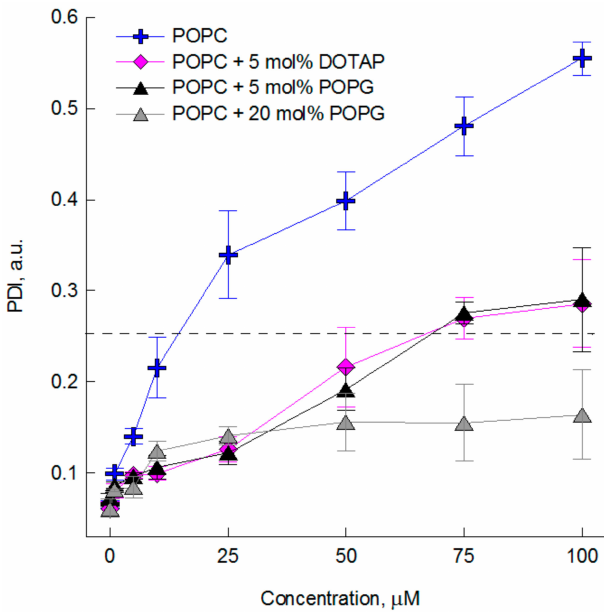
Figure 3. The polydispersity index (PDI) values of LUVs formed from zwitteronic lipids (POPC) and with positive (POPC-DOTAP) and negative (POPC-POPG) charge net. The measurements were performed 15 min after cyanidin addition (10–100 µ M). Results are shown as mean ± SD. PDI above which the liposome aggregation was observed is marked with a dashed line. POPG is 1-palmitoyl-2-oleoyl-sn-glycero- 3-phospho-glycerol and DOTAB is